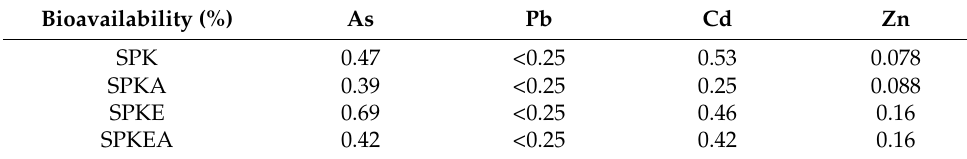
Table 2. The percentage of the bioavailable fraction (CaCl 2 extraction) of heavy metal (As, Cd, Pb, and Zn) in the total fraction in different layers of mixed soil after cultivation of K. pentacarpos in the presence and absence of NaCl or/and EDDS for 5 months. The sample was tested once. Bioavailability (%) As Pb Cd Zn